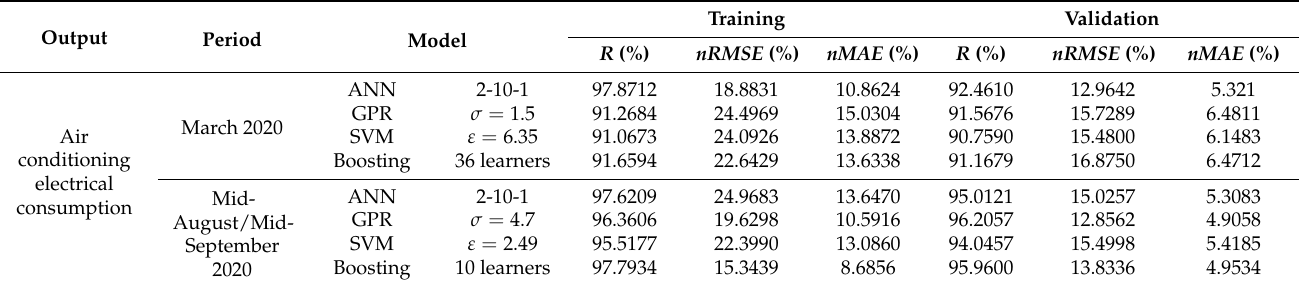
Table 1. The models’ performance in predicting the air conditioning electrical consumption (March, mid-August to mid-September).